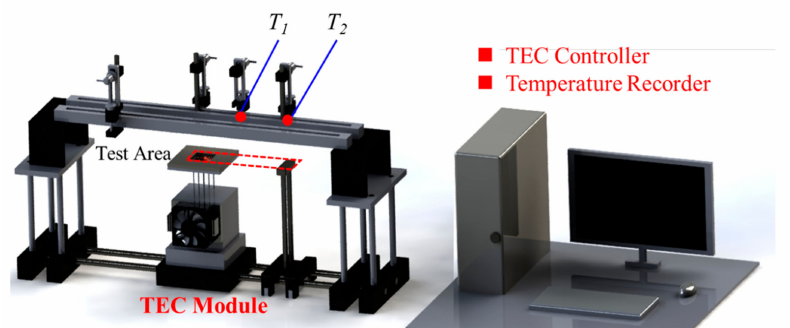
Figure 3. One-dimensional heat transfer measurement setup.